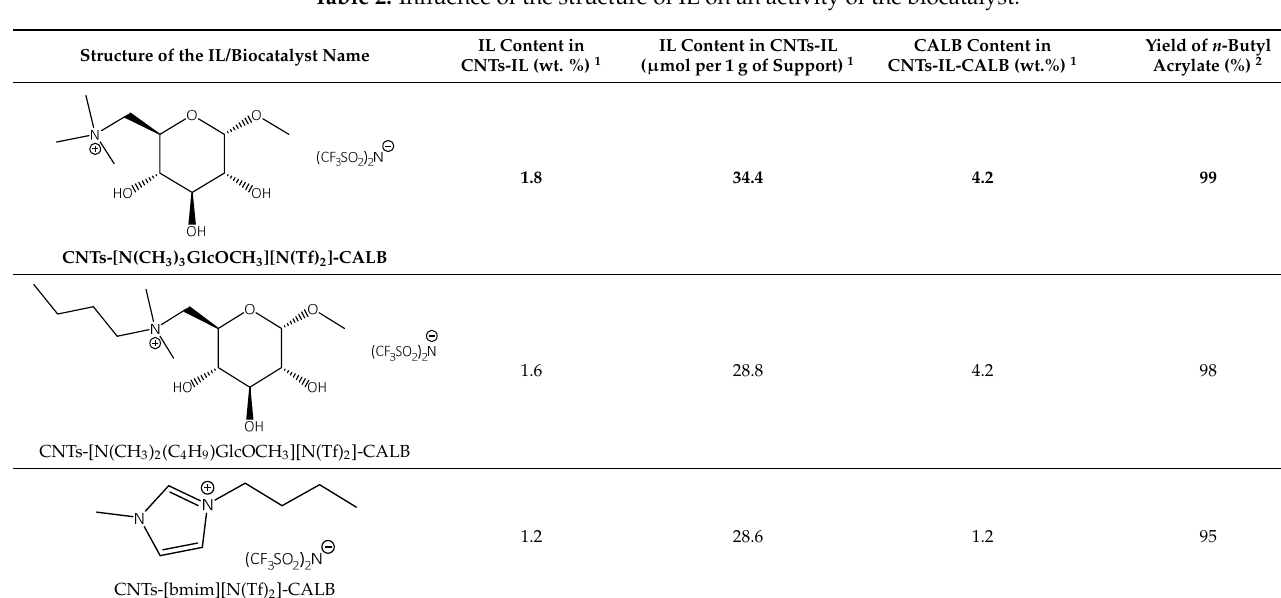
Table 2. Influence of the structure of IL on an activity of the biocatalyst.